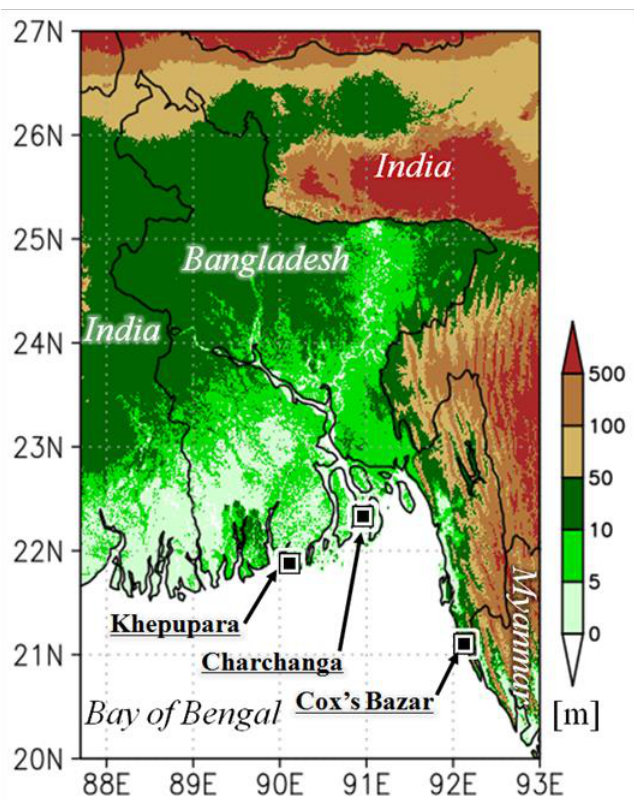
Figure 1. Topography around the Bangladesh coast and the locations of the selected study sites. The Cox’s Bazar station is located at 21.45° N and 91.95° E, Charchanga at 22.22° N and 91.06° E, and Khepupara at 21.85° N and 90.08° E.